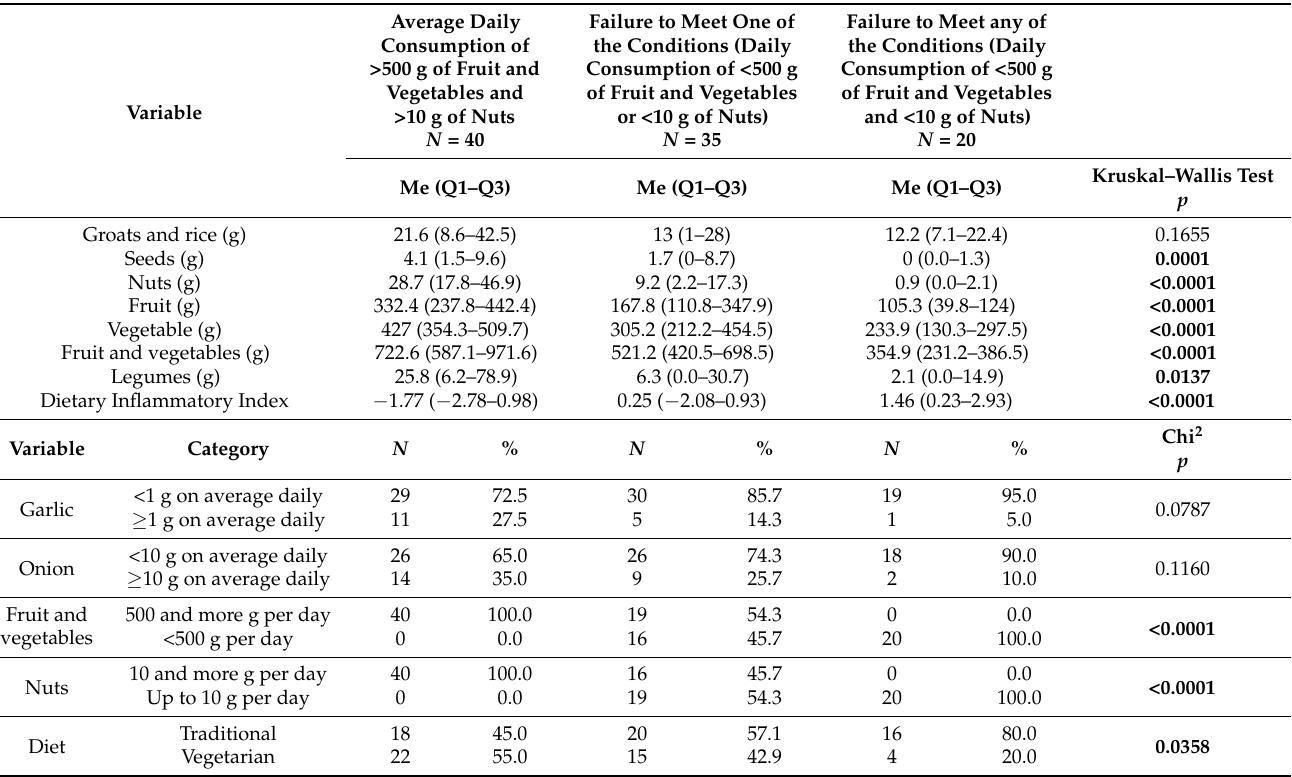
Table 6. Dietary Inflammatory Index and consumption of selected food products by respondents divided according to compliance with the recommended consumption of vegetables, fruit, and